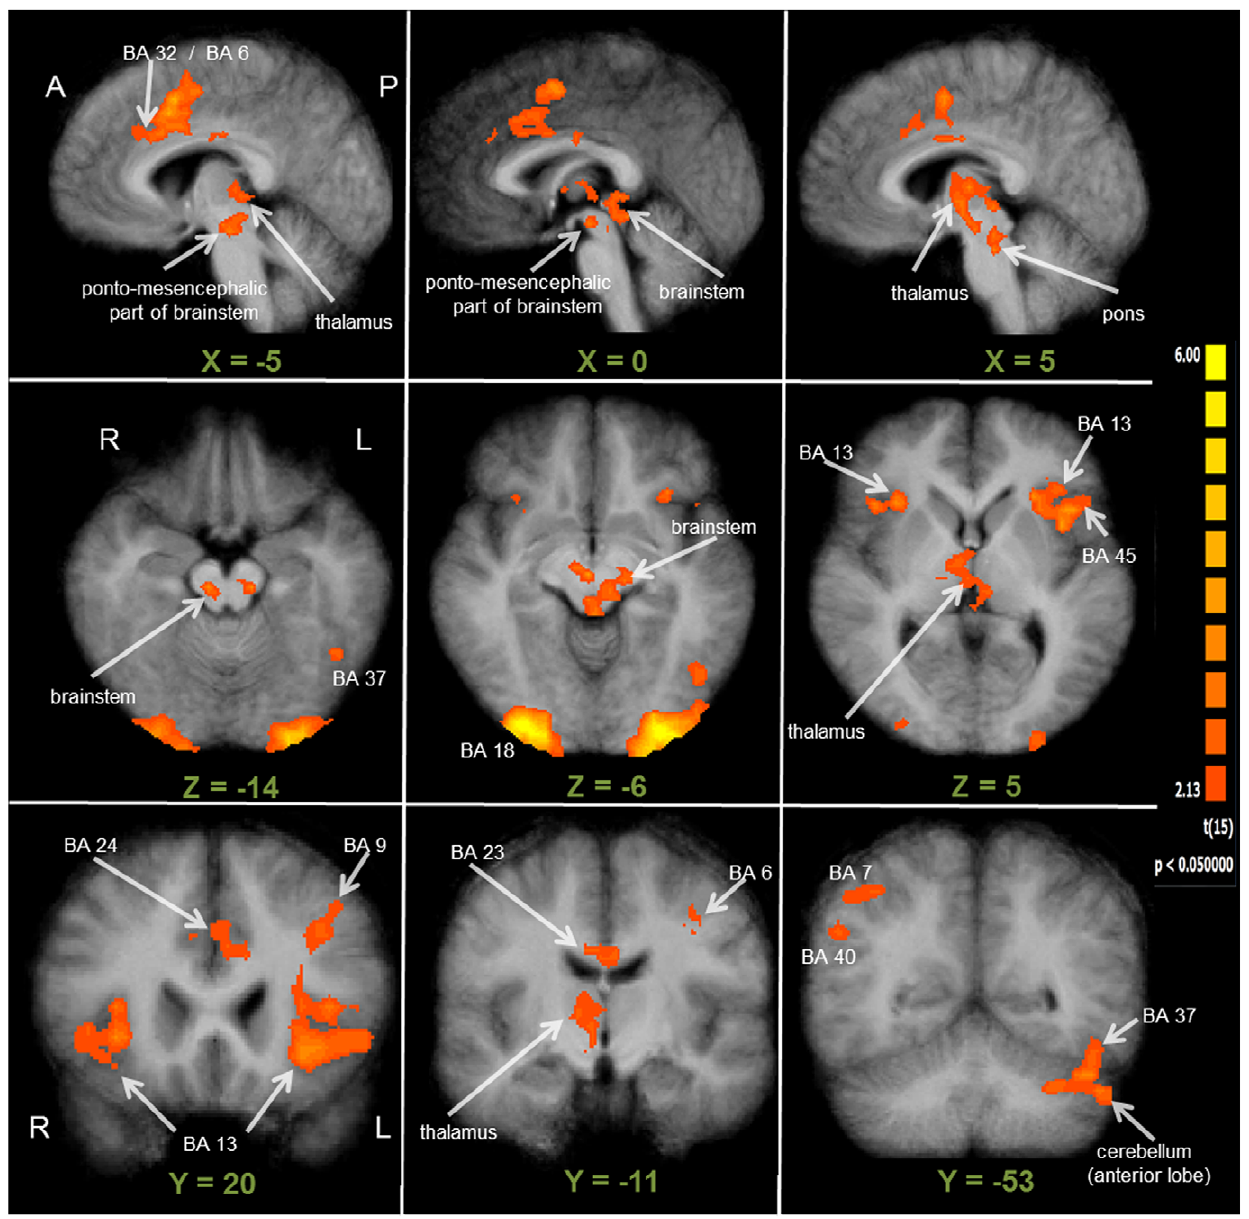
Figure 3. Whole-brain results of the first part of the fMRI analysis (RFX-GLM; n =16). All clusters of activation displayed here are derived from the contrast Intrinsic Alertness Task . Control Task, depicting the same contrast as in Figure 2. For better visualization, especially for subcortical and thalamic structures, this figure shows the results being projected onto the average brain of all 16 participants. At the individual voxel-level, significant activations were thresholded at p =0.05 (uncorrected). Additionally, a cluster-size threshold of k=34 voxels was applied, which together resulted in a cluster-level false-positive rate of 5% (whole-brain corrected p =0.05). The first row depicts sagittal slices, covering all activations located close to the midline and the medial part of the brain. Transversal slices, covering the brainstem and the thalamus, are shown in the second row. The third row depicts three coronal slices, illustrating the frontal, parietal and thalamic activations, and the activation within the cerebellum, extending into the fusiform gyrus (BA 37). All results are shown in radiological convention. (A=anterior; BA=Brodmann area; P=posterior; R=right hemisphere; L=left hemisphere) .